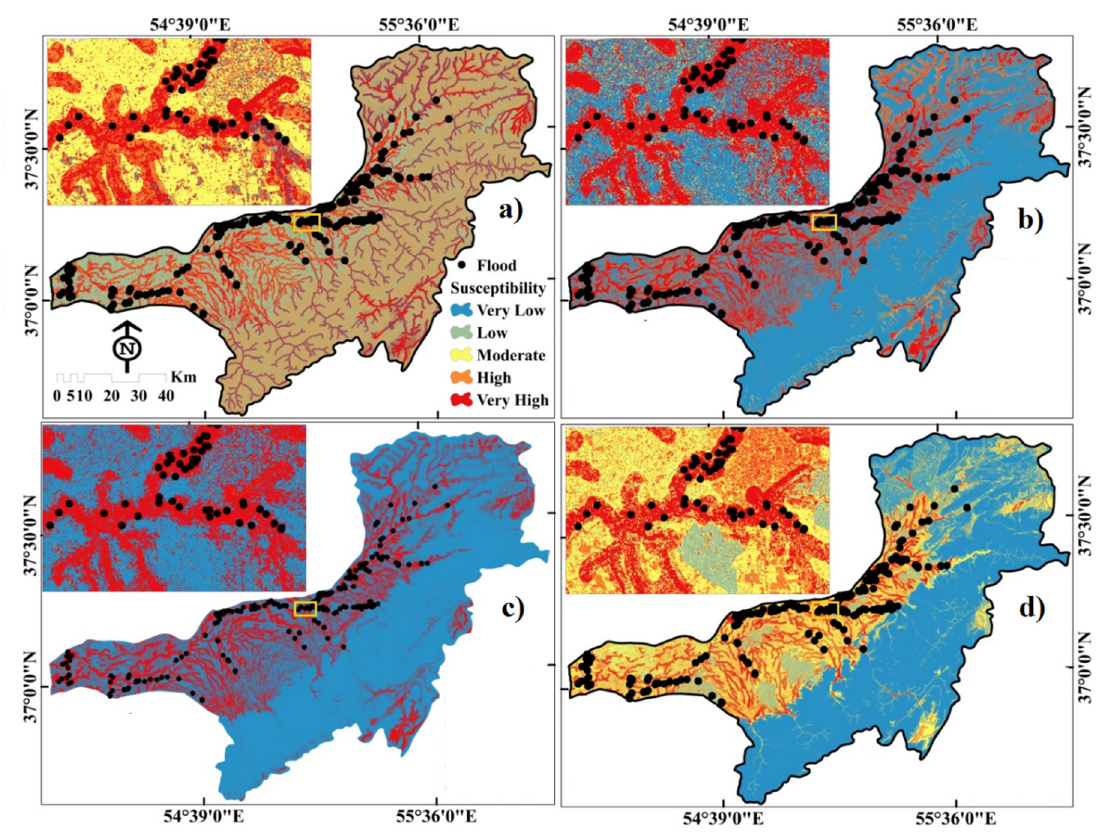
Figure 6. Flood susceptibility mapping, ( a ) J48 model, ( b ) MultiBoosting J48 (MJ48) model, ( c ) real AdaBoost J48 (RJ48) model, ( d ) Random Subspace J48 (RSJ48) model.